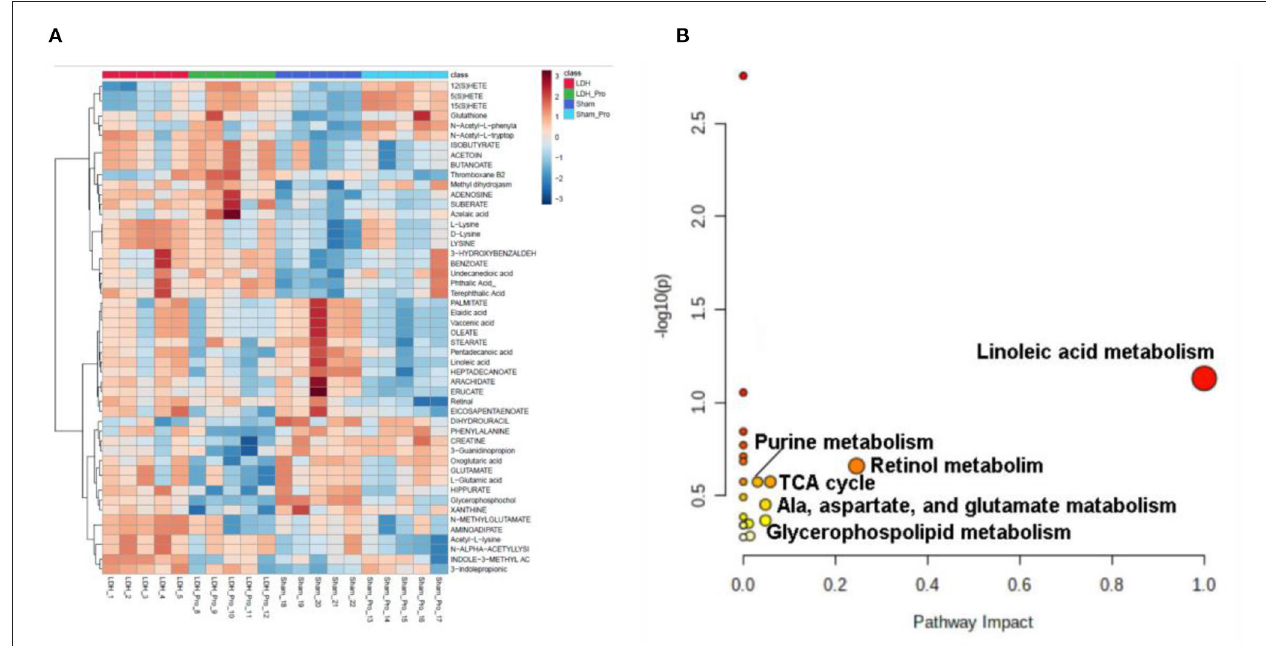
FIGURE 6 | L. paracasei S16 changed serum metabolomics changes. (A) Heat-map of the intensity of 32 significantly different metabolites showing significantly different metabolic profiles between the Sham, Sham + Probiotic, LDH, LDH + Probiotic groups. (B) The disturbed metabolic pathways showed differential metabolites by MetaboAnalyst 5.0 software. Node radius was based on pathway impact values. Node color was based on P